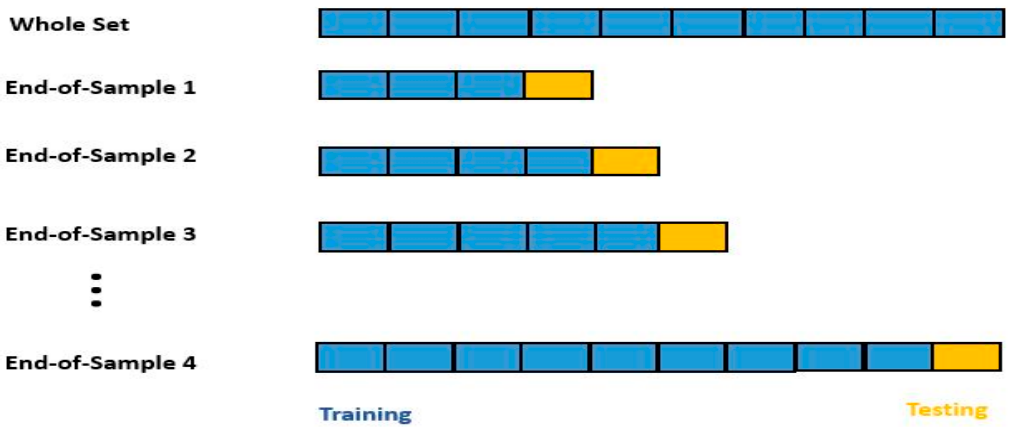
Figure 7. Diagram of the time series 4-sliding window validation method. Adapted from LaBarr (2018).